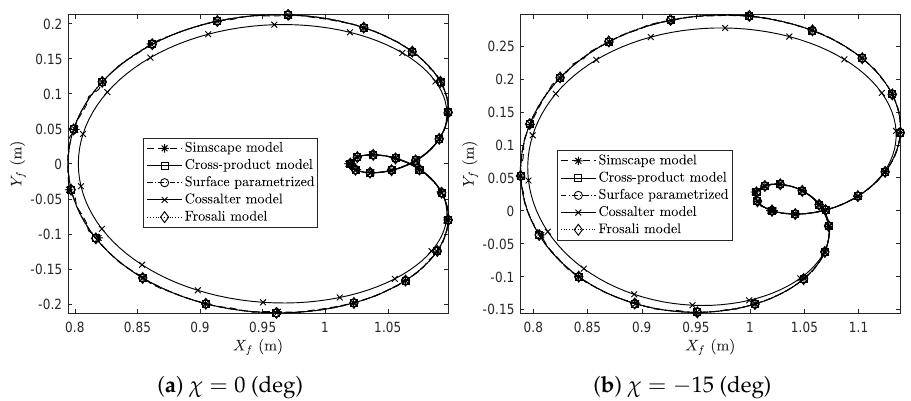
Figure 9. Front wheel contact point trajectory for a complete rotation of the vehicle handlebars. ( a ) presents the trajectory of the contact point for a constant roll angle of the rear frame equal to zero. ( b ) presents the trajectory of the contact point for a constant roll angle of the rear frame equal to χ = − 15 (deg).